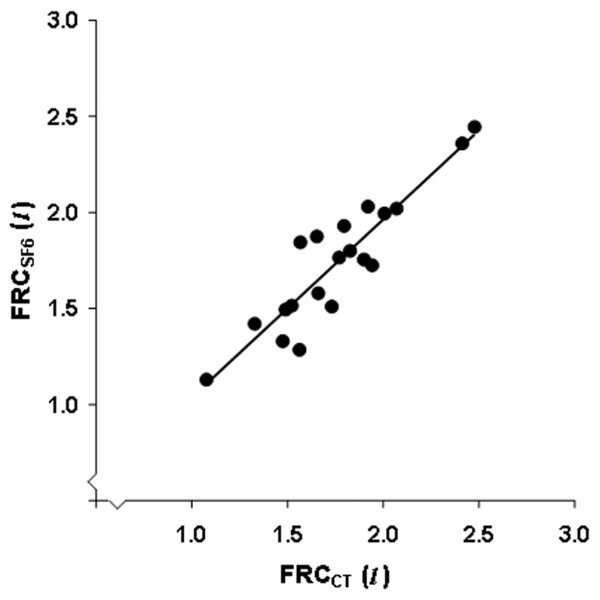
Linear regression between FRC measurements by rebreathing of sulphur hexafluoride (FRCSF6) and by computed tomography (FRCCT) in 20 healthy subjects. The dotted line is the regression line: EELVSF6 = 0.9FRCCT + 0.1 (r2 = 0.83; P < 0.001).